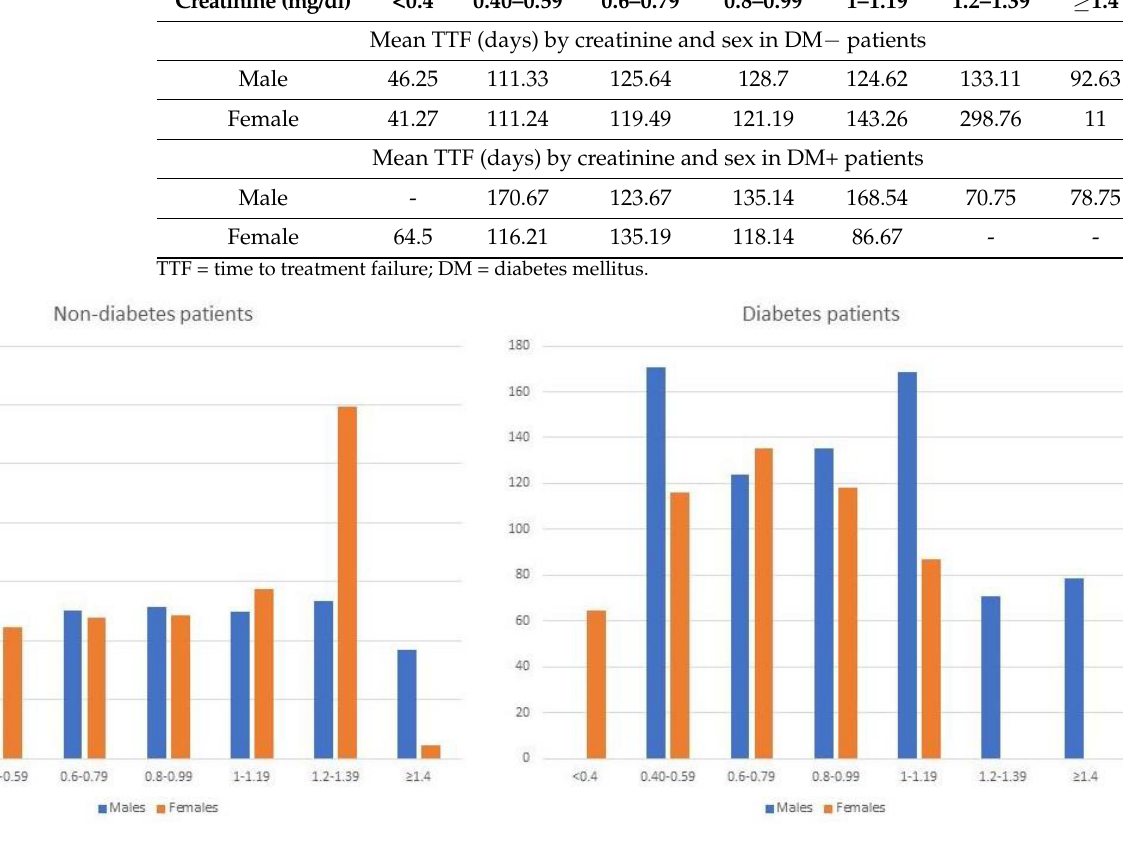
Figure 7. Graphic presentation of average TTF by creatinine and gender in patients with and without DM. Figure 7. Average TTF by creatinine and gender in patients with and without DM. Table 5. Comparison of creatinine values by gender and DM Table 5. Comparison of creatinine values by gender and DM status.